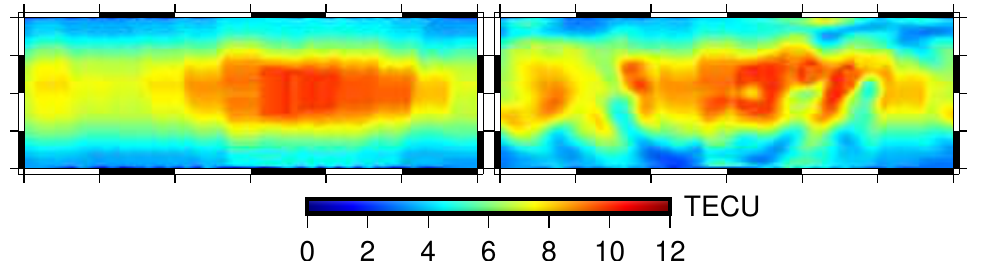
Figure 7. VTEC map of the top region at 16:00–18:00 UTC on DOY 089, 2012: ( left ) the model constructed by the method of Wu et al.’s; and ( right ) the model that was re-assimilated using podTec with the constructed